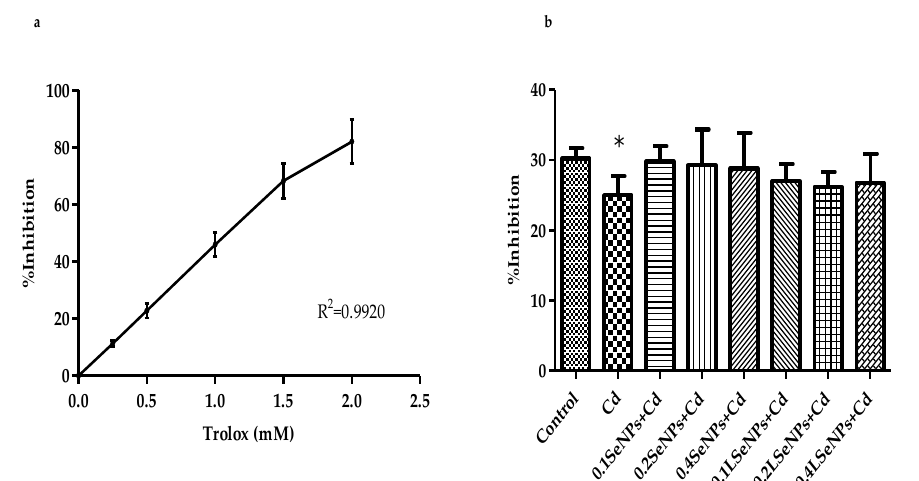
Figure 3. ( a ). Trolox concentrations-response curve of % Inhibition of ABTS • + , recorded at 734 nm. Five different standard concentrations (between 0.25 and 2 mM Trolox) were used in triplicate. ( b ).The % Inhibition of ABTS • + from blood mice after 30 days treatments. All values were expressed as mean ± SD for 10 mice in each group. Statistically significant difference at * p < 0.05. Groups: Control-mice received only water; Cadmium group (Cd)-mice received orally 5 mg/kg CdCl 2 ; 0.1 SeNPs + Cd (0.1 mg/kg SeNPs + 5 mg/kg CdCl 2 ); 0.2 SeNPs + Cd (0.2 mg/kg SeNPs + 5 mg/kg CdCl 2 ); 0.4 SeNPs + Cd (0.4 mg/kg SeNPs + 5 mg/kg CdCl 2 ); 0.1 LSeNPs + Cd (0.1 mg/kg LSeNPs + 5